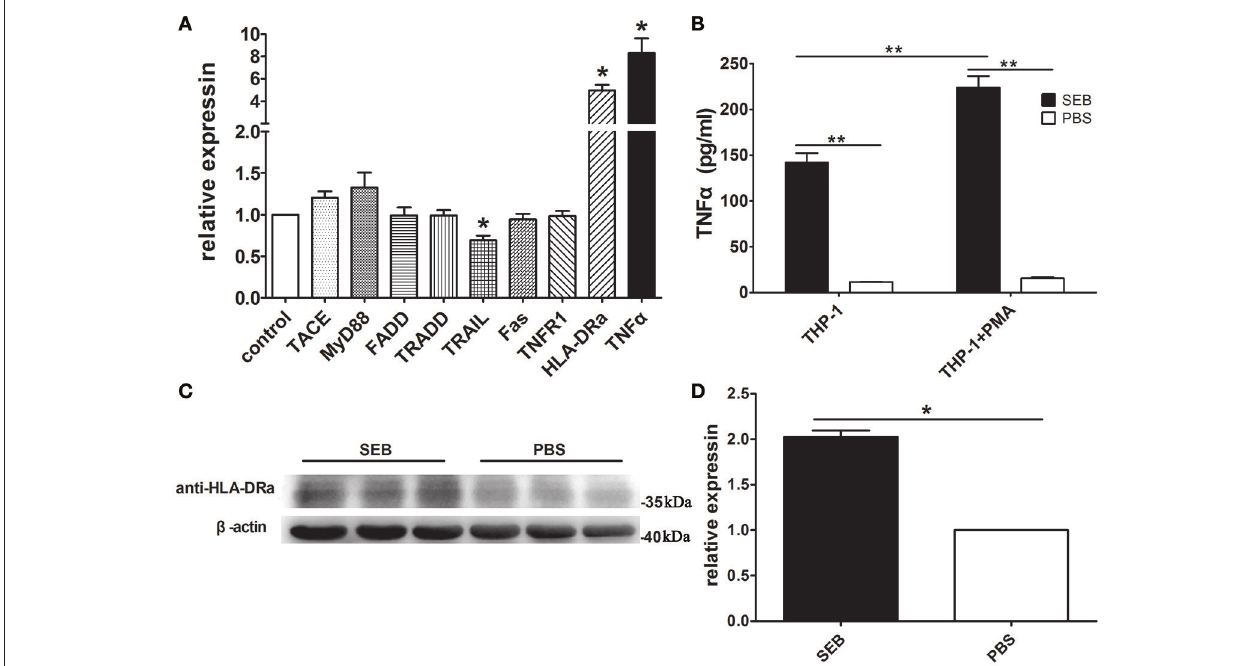
FIGURE 5 | SEB up-regulated TNF α and HLA-DRa expression. (A) THP-1 cells (2 × 10 6 per well) were inoculated in 6-well-plates and treated with 20 µ g/ml SEB (80 µ l/well) or 80 µ l/well PBS for 36 h. qRT-PCR was conducted, as described in Materials and Methods. The mRNA levels of TACE, MyD88, TNFR1, HLA-DRa, TNF α , FADD, TRADD, TRAIL, and Fas were determined with their respective specific primers and normalized to the GAPDH expression. Data are presented as means ± S.D. ( n = 4), *represented P < 0.05 vs. PBS control. (B) THP-1 cells and PMA-differentiated THP-1 cells (2 × 10 5 per well in 24-well-plates) were treated with 20 µ g/ml (24 µ l/well) SEB or 24 µ l/well PBS for 36 h. The secreted TNF α in the culture supernatants was quantified through ELISA. Data are presented as means ± S.D . ( n = 3), **indicated P < 0.01 vs. PBS control. (C) THP-1 cells (2 × 10 6 per well) were inoculated in 6-well-plates and treated with 20 µ g/ml SEB (80 µ l/well) or 80 µ l/well PBS for 36h. The HLA-DRa expression was determined through Western blot. (D) Quantitative analysis results with ImageJ software are presented as means ± S.D . ( n = 3), *represented P < 0.05 vs. PBS control.